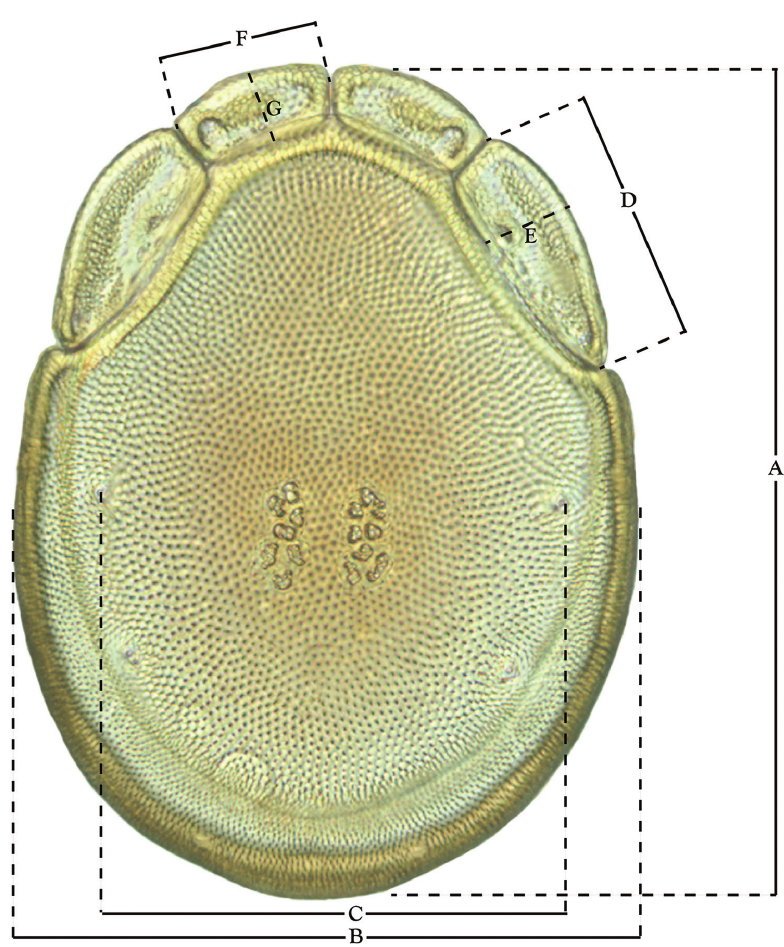
Figure 4. Dorsal measurements: A dorsal length B dorsal width C distance between dorsal glandularia, Dgl-4 D anterio-lateral platelet length E anterio-lateral platelet width F anterio-medial platelet length G anterio-medial platelet width. T. multiforma Habeeb, 1974